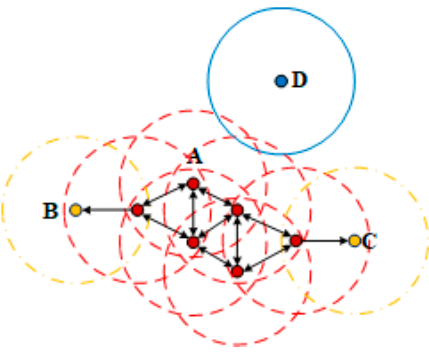
Figure 2. Illustration of the DBSCAN algorithm.